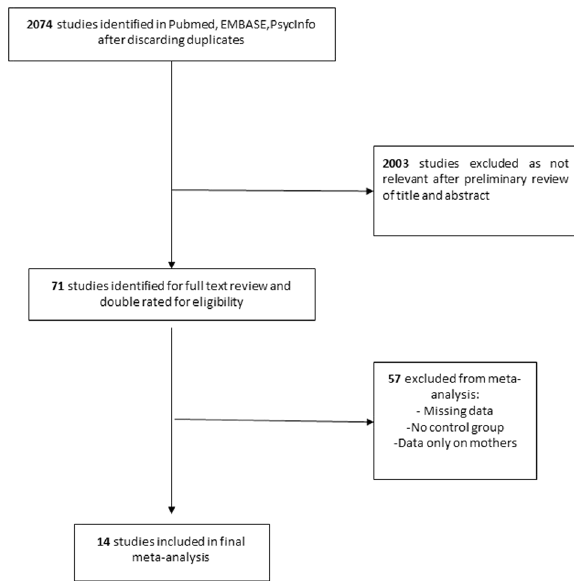
Fig. 1 Flowchart of the selection process for studies